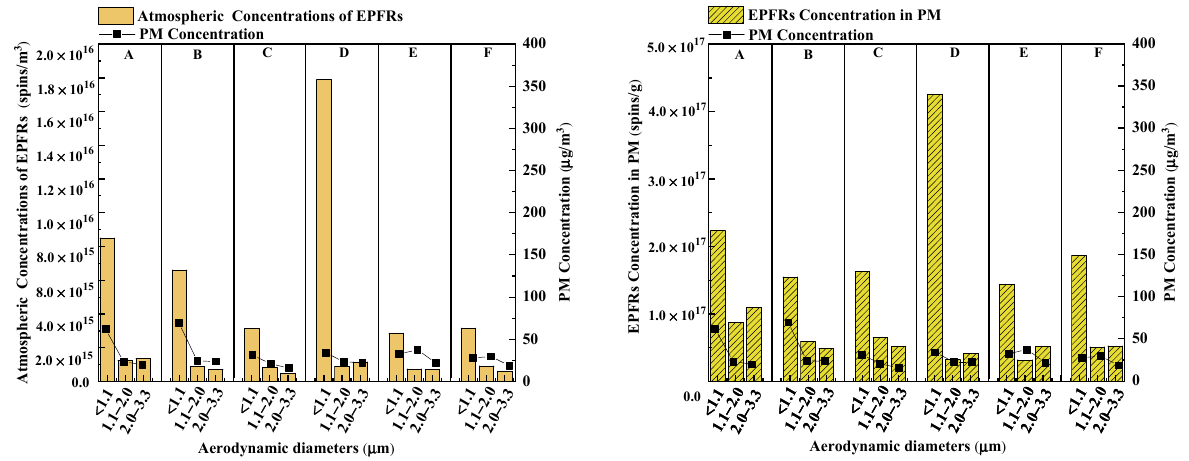
Figure 3. EPFRs and PM concentrations in atmospheric particulate matters from Xuanwei. (The left : the atmospheric EPFRs concentrations; the right : EPFRs concentrations in PM). Table 4. Size distribution of EPFRs and PM in atmospheric particulate matters from Xuanwei (%). Sample